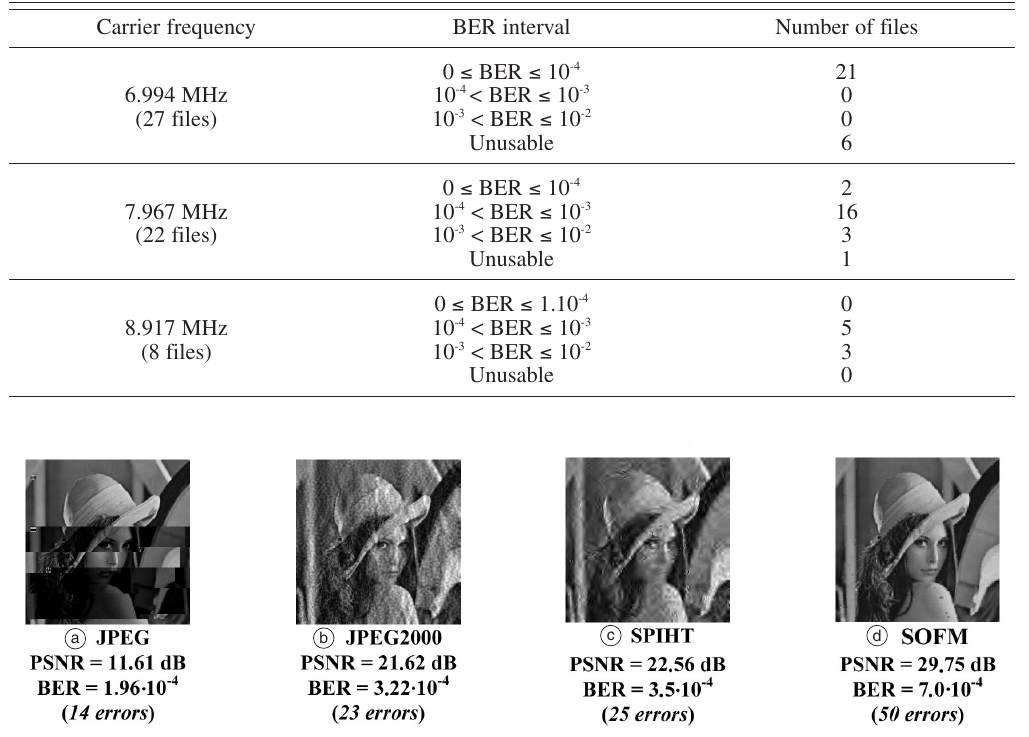
Fig. 13.30a-d. Images received using different number of